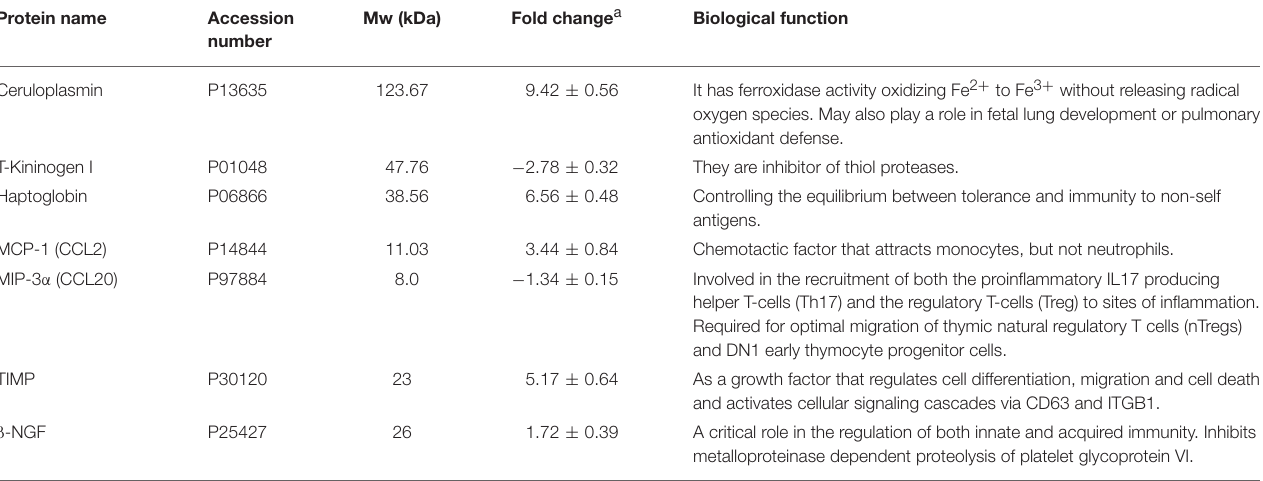
TABLE 1 | Lists of proteins/cytokine expressed differentially between POD14 and